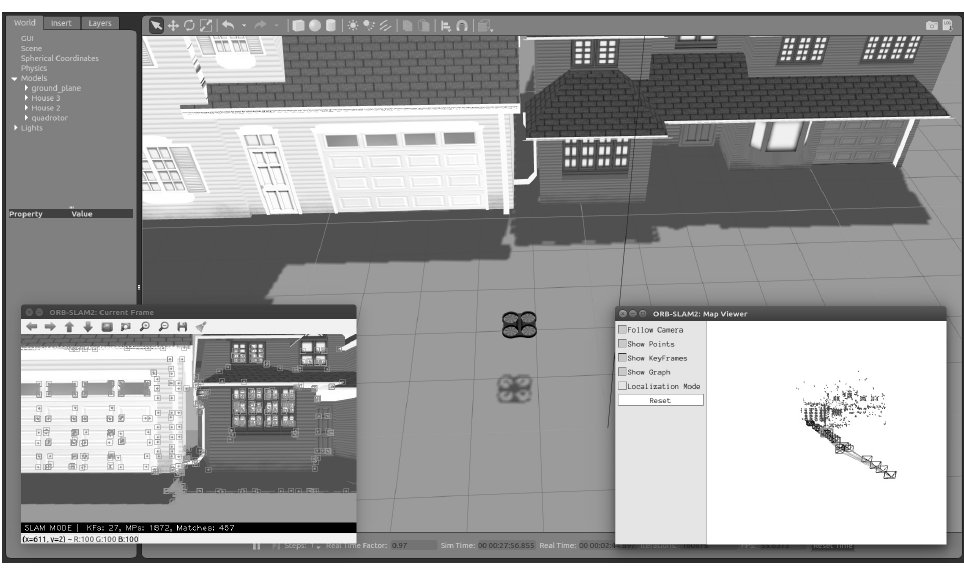
Figure 5. Gazebo environment.